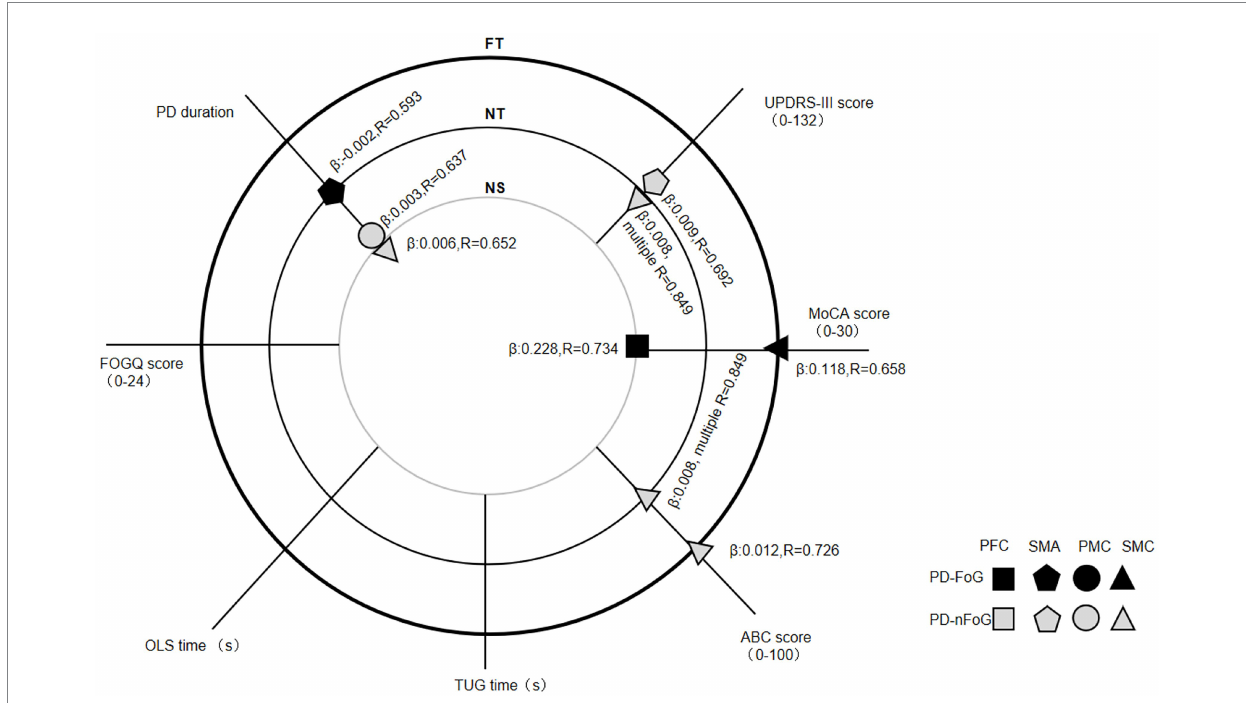
FIGURE 3 Regression analysis results on the correlation between clinical features and cortical activation in each ROI during different locomotion tasks within each PD patient group. The three big circles with a thin grey line (inner), thin black line (middle), and bold black line (outer) indicate locomotion tasks of normal stepping (NS), normal turning (NT) and fast turning (FT), respectively. The small icons with shape of a square, pentagon, circle and triangle denote the cortical activation in PFC, SMA, PMC and SMC, respectively. The black and grey icons denote the groups of PD-FoG patients and PD-nFoG patients, respectively. An icon with information of ROI and group, marking at the cross of a clinical feature line, and a task circle denoted that the clinical feature is a significant determinant of the activation in the specific ROI during the specific task of the specific group. For each significant determinant, the coefficient in estimated regression equation ( β ) and the strength of the linear relationship (R) are reported. PD-FoG, Parkinson’s disease with freezing of gait; PD-nFoG, Parkinson’s disease without freezing of gait; PFC, prefrontal cortex; PMC, premotor-motor cortex; SMA, supplementary motor area; SMC, sensorimotor cortex; ROI, region of